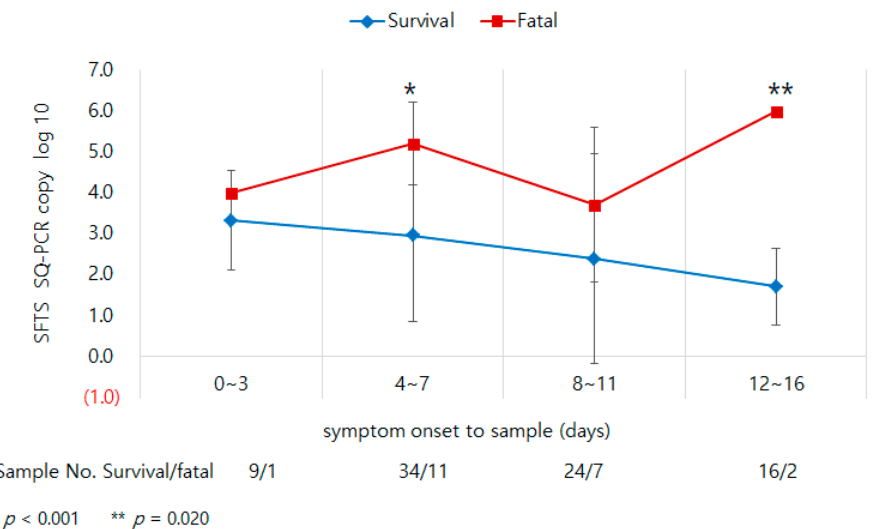
Figure 1. Comparison of SFTS SQ-PCR copy numbers between the survival group ( n = 34) and the fatality group ( n = 9) during the first week (days 0–7) from symptom onset to the time of sampling. Kinetics of SFTS viral copy numbers in blood specimens collected after symptom onset. Kinetics of the log 10 SFTS SQ-PCR copy in the survival group and the non-survival group from symptom onset to the time of sampling. * p < 0.001, ** p = 0.020.